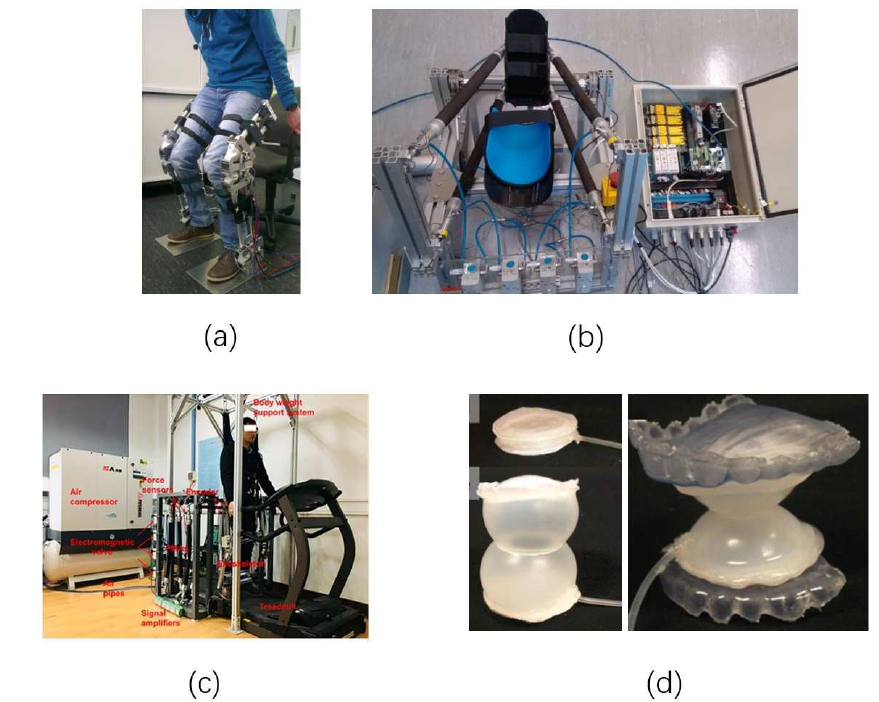
Figure 4. Soft rehabilitation and nursing-care robots based on pneumatic fiber braided fabrics and elastic polymers in other parts of body. ( a ) is reprinted from [70]. ( b ) is reprinted from [71]. ( c ) is reprinted from [72]. ( d ) is reprinted from